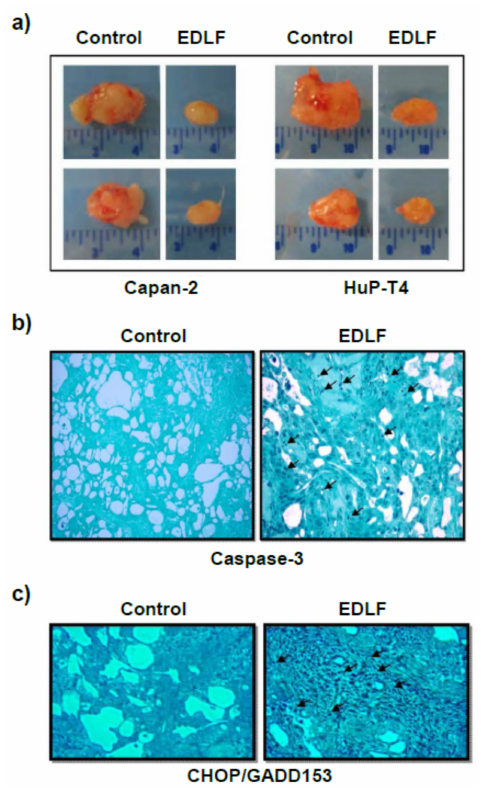
Figure 10. In vivo antitumor activity of edelfosine on human pancreatic cancer xenograft models. ( a ) CB17 SCID mice were inoculated subcutaneously with Capan-2 or HuP-T4 pancreatic cancer